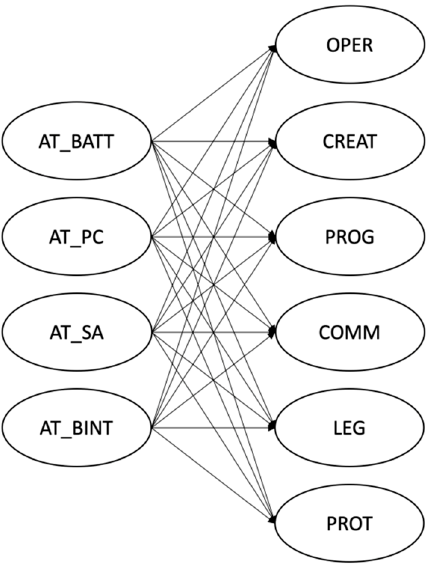
Figure 1. Theoretical model of attitudes predicting the variance of digital competence dimensions (AT_BATT—behavioural attitudes, AT_PC—perceived control, AT_SA—social aspects, AT_BINT—behavioural intention, OPER—performing operations with digital tools, CREAT—creating digital materials, PROG—programming digital content, COMM—communicating in the digital world, LEG—legal behaviour in the digital world, PROT—protecting oneself and others in the digital world).